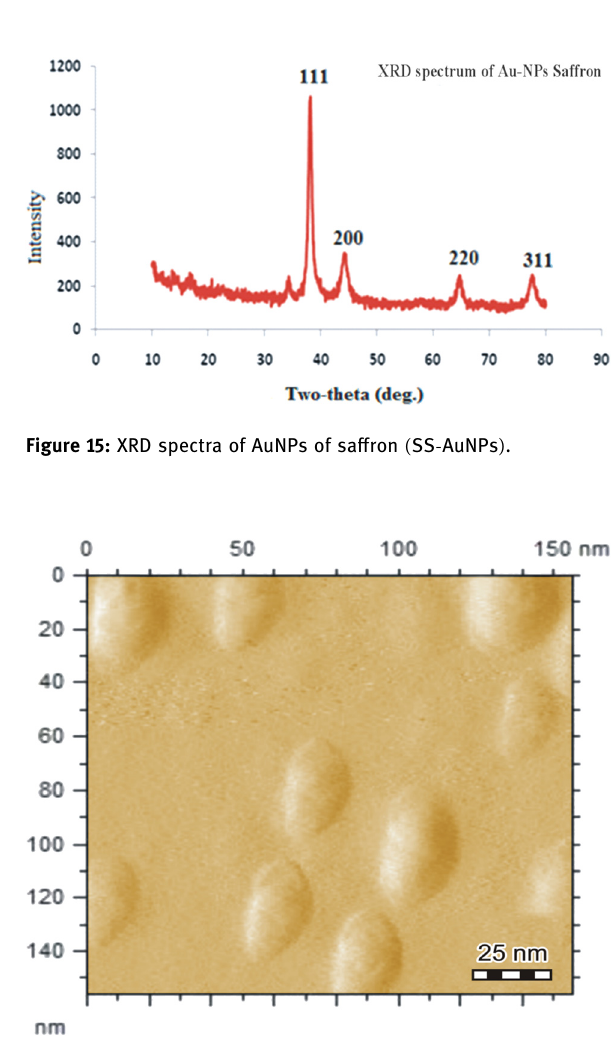
Figure 16: AFM image of AuNPs of sa ff ron ( SS - AuNPs ) .